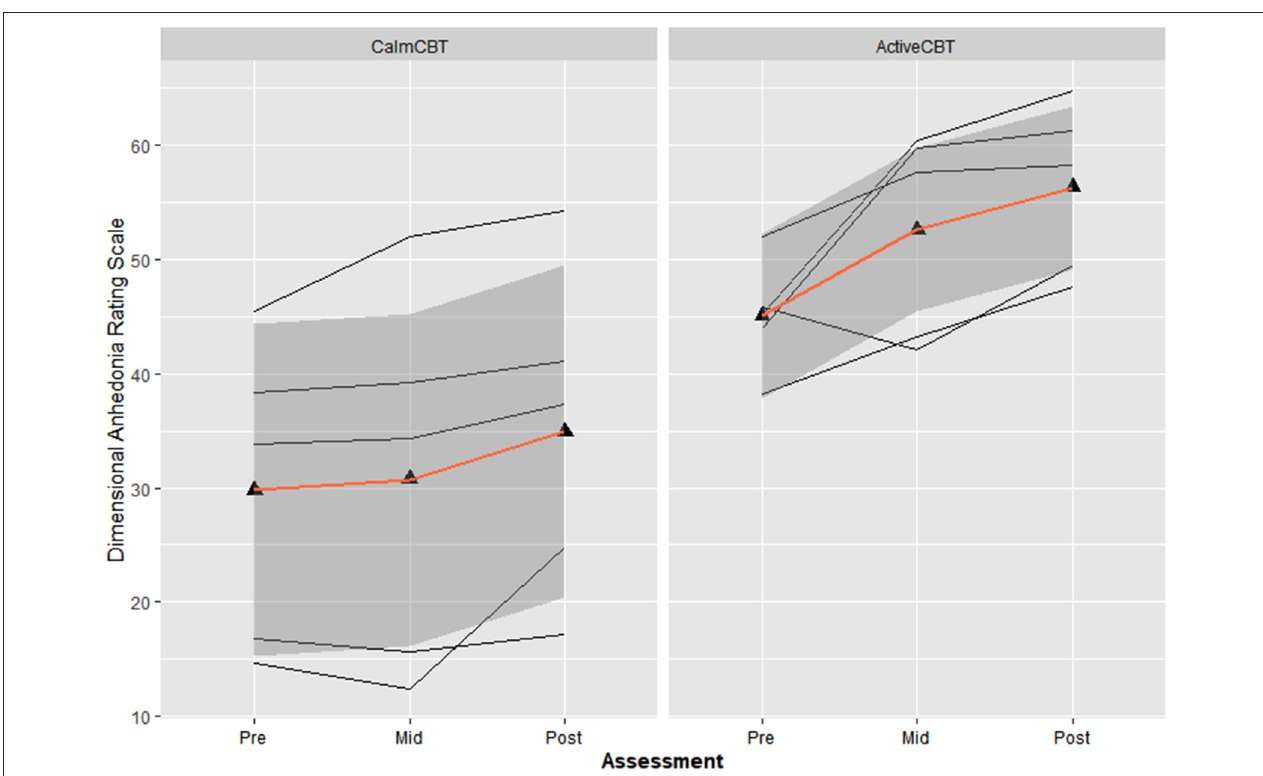
FIGURE 3 | Changes in dimensional anhedonia rating scale (DARS) within sessions by group. Average changes across all 8 visits in the total score of the DARS immediately before the Active or Calm condition (i.e., Pre-Condition), immediately after (i.e., Post-Condition) and immediately after the 50-min CBT session (i.e., Post-Therapy). Higher scores indicate lower levels of anhedonia.